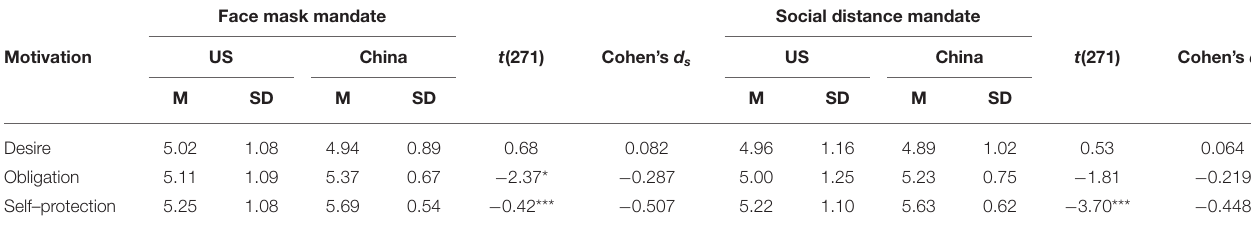
TABLE 8 | Descriptive data for the belief of the protagonist’s motivation—Chinese and American participants. Face mask mandate Social distance mandate